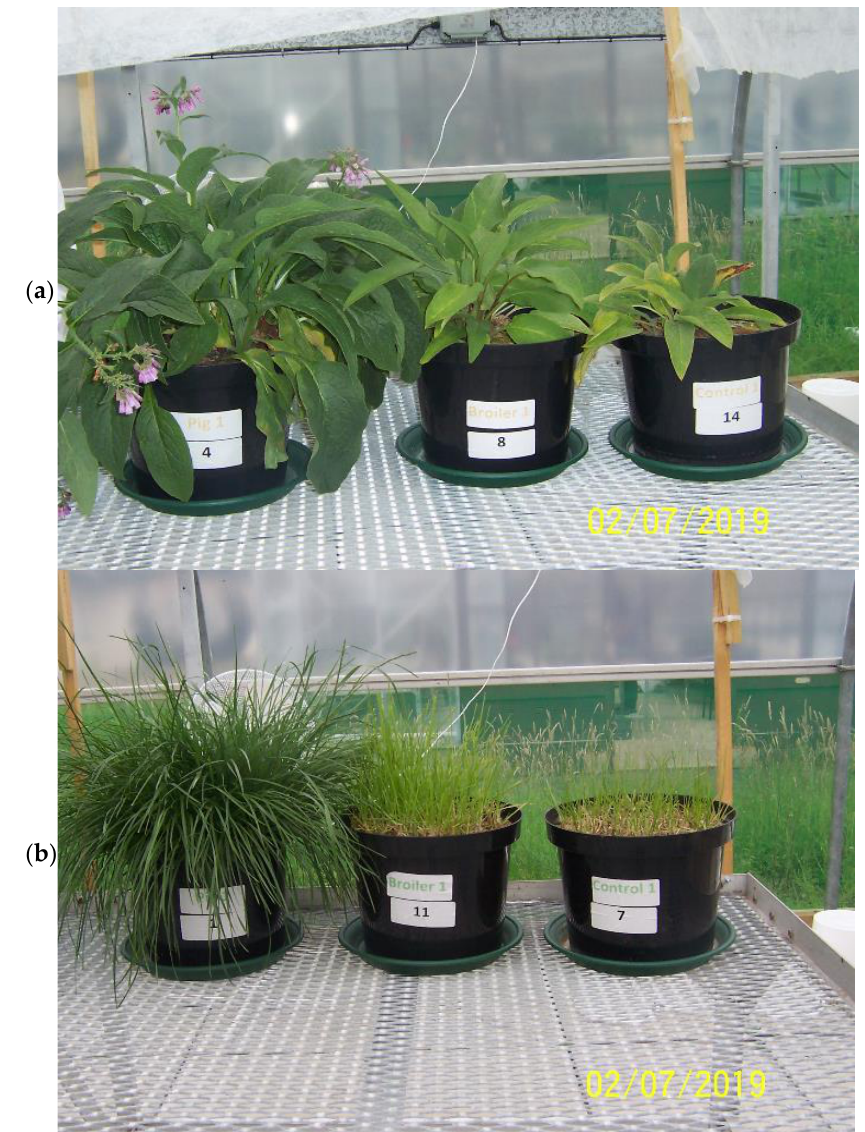
Figure 1. Example of growth response of two plant species namely, Comfrey ( Symphytum x uplandicum ; ( a )) and Italian ryegrass ( Lolium multiflorum ; ( b )) to different fertilisation treatments including (from right to left in the photo) control (no fertiliser applied), broiler litter and pig slurry all applied at rates of 30 kg P ha −1 and 250 kg N ha −1 . The photo was taken on 2 July 2019 after a ~3 month-long growing period under controlled greenhouse conditions.